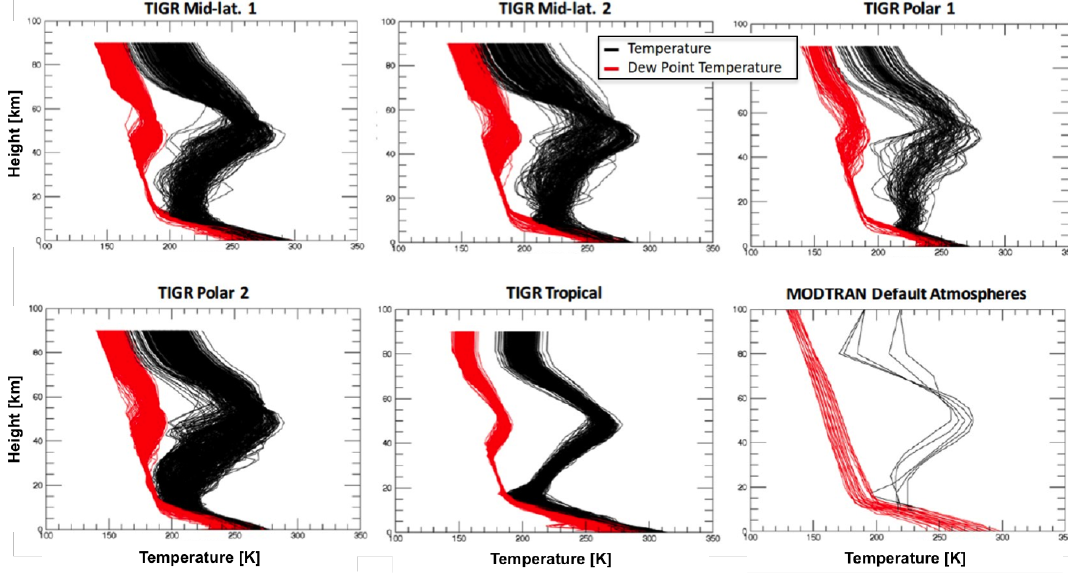
Figure 2. TIGR atmospheric profiles for various atmospheric types compared to MODTRAN’s default atmospheres. The black data curves are air temperatures as a function of altitude, while the red data curves are the associated dew point temperatures.